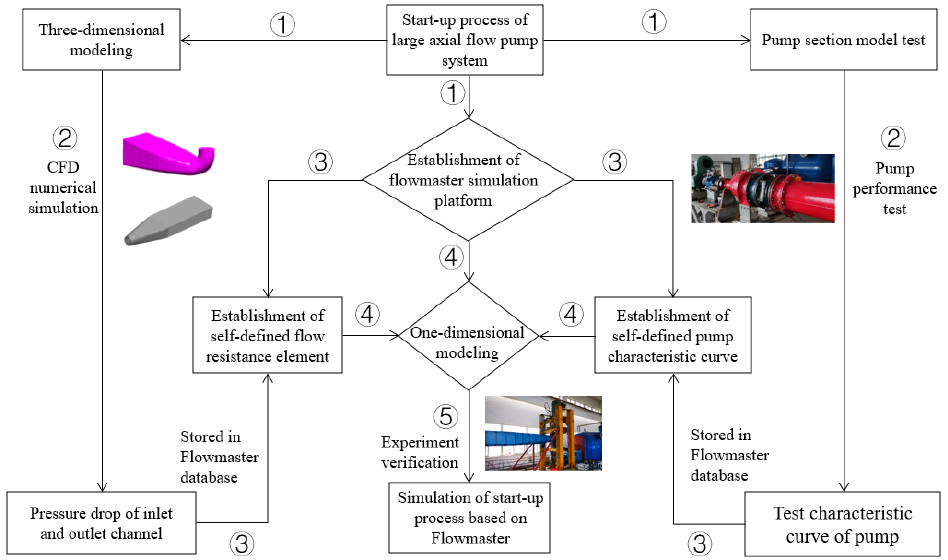
Figure 2. Flowchart of the shutdown process simulation strategy.